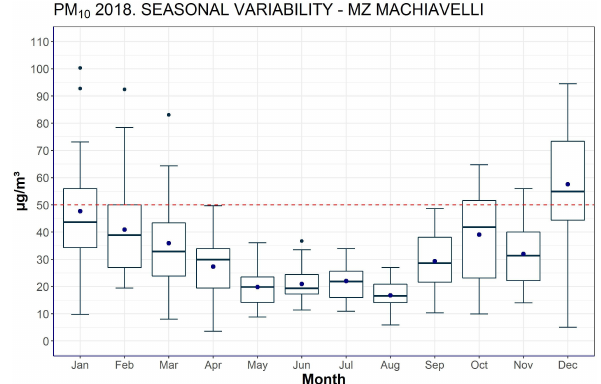
Figure 12: Monza, PM 10 daily averages distribution by month, show- ing typical seasonal